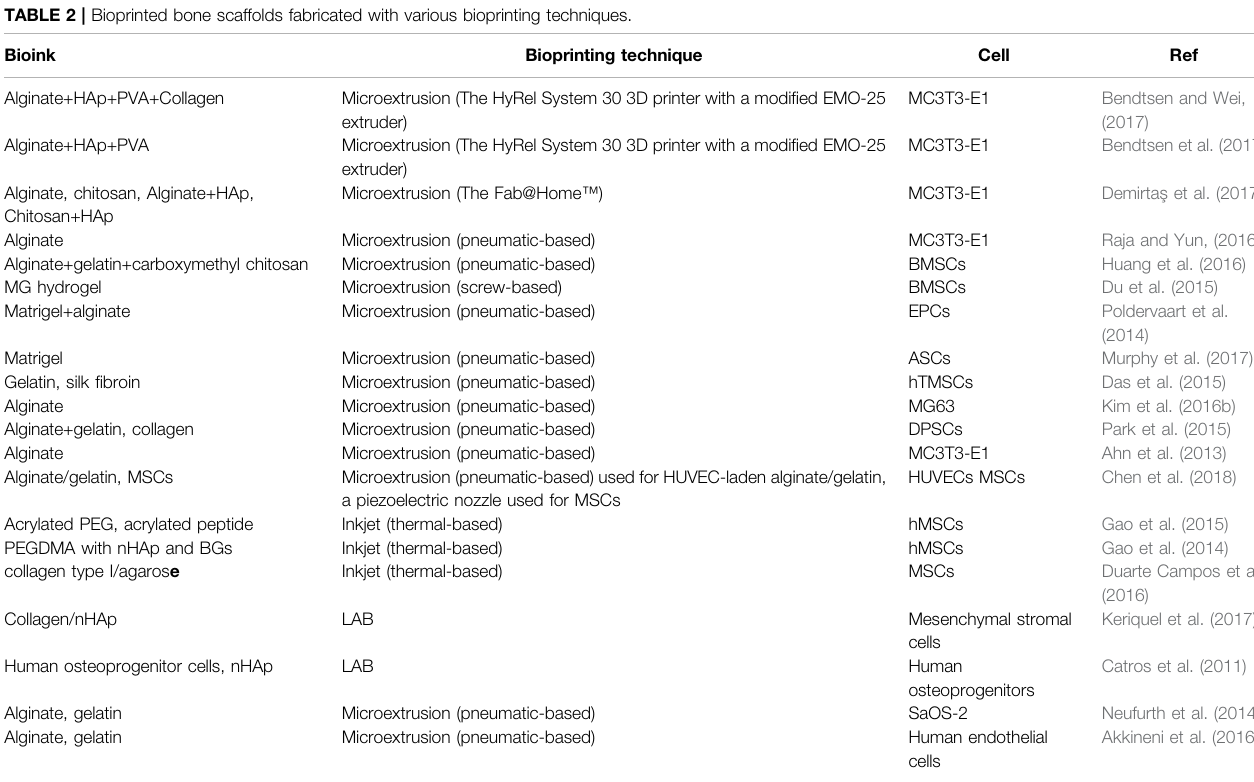
TABLE 2 | Bioprinted bone scaffolds fabricated with various bioprinting techniques.